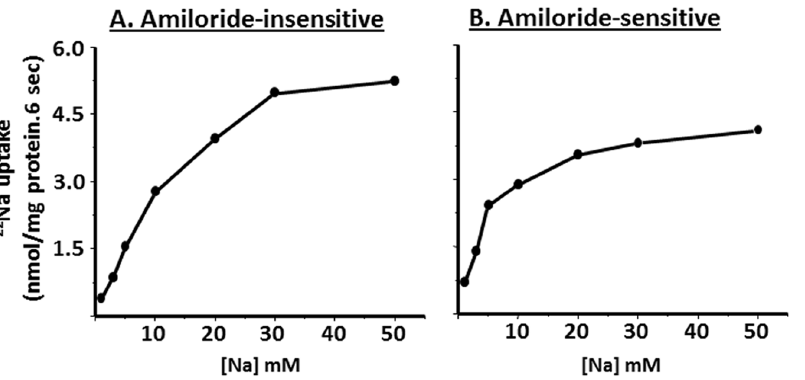
Figure 6. Kinetics of Na-HCO 3 cotransport activities in basolateral membrane vesicles from proximal colon. Increasing extravesicular Na concentrations (1–50 mM) saturate both amiloride-insensitive and amiloride-sensitive proton/HCO 3 gradient-driven 22 Na uptake with apparent Km for Na of 7.3 6 0.6 and 4.3 6 0.3 mM, respectively. Proton/HCO 3 gradient-driven 22 Na uptake was measured as described in the Method section with increasing extravesicular Na concentrations both in presence and absence of inhibitors (either 1 mM amiloride or 1 m M HOE694). Uptake obtained in presence of amiloride represented amiloride-insensitive proton/HCO 3 gradient-driven uptake. Amiloride-sensitive uptake (which also includes HOE694 sensitive Na-H exchange) was calculated by subtracting uptake obtained in presence of amiloride from that of uptake in the absence of inhibitors. HOE694-sensitive uptake was calculated by subtracting uptake obtained in presence of HOE694 from that of uptake in the absence of inhibitors. Amiloride-sensitive proton/HCO 3 gradient-driven uptake was calculated by subtracting HOE694-sensitive uptake from that of amiloride-sensitive uptake. Best fit curves were drawn using Michaelis-Menten equation. The kinetic constants were calculated using a nonlinear regression with the EnzFitter software (Biosoft, Cambridge, UK).